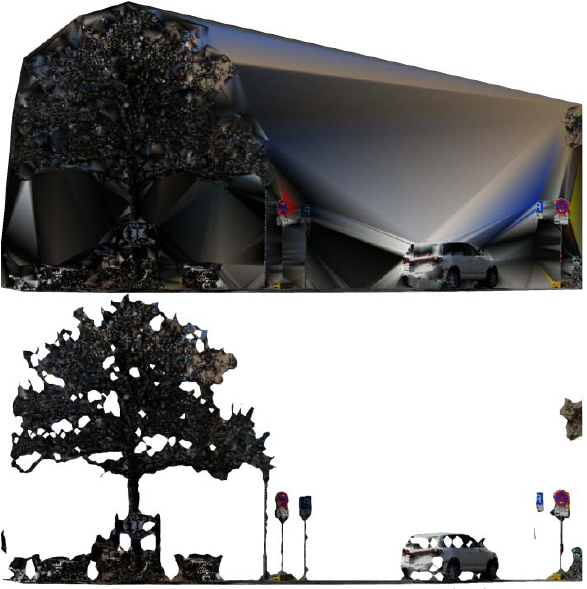
Figure 8. Color interpolation - entire convex hull (top) - triangle size treshold